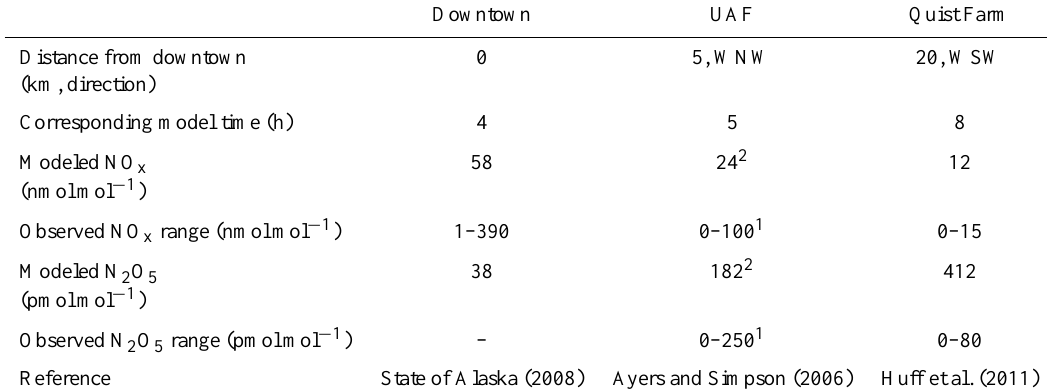
Table 2. Field observations of NO x from downtown Fairbanks, University of Alaska Fairbanks (UAF), and the Quist Farm as well as related model results. A wind speed of 1ms − 1 and distance from downtown was used to calculate corresponding model time. Observations at UAF were performed at an elevation 80m above the valley floor ( 1 ) and compared to modeled values in layer centered at 75m ( 2